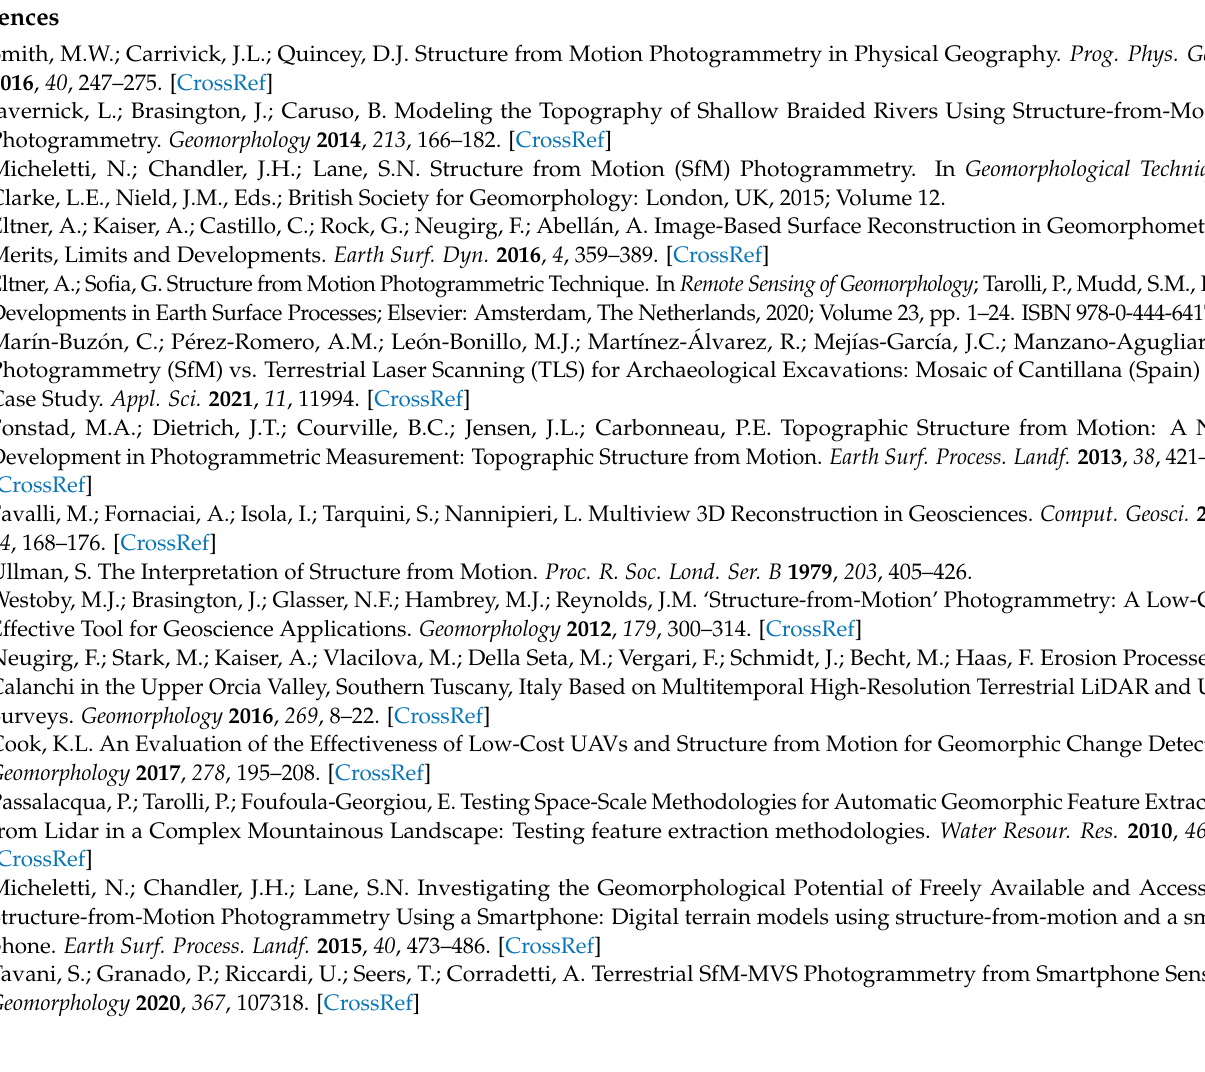
Figure A4. ( a ) 201718 Terr, ( b ) 201718 UAV, ( c ) 201819 Terr, ( d ) 201819 UAV, ( e ) 201719 Terr and ( f ) 201719 UAV. ( a – f ): Local level of detection for the multitemporal comparison of point clouds resulting from using terrestrial and aerial imagery in the 3D reconstruction. Gray colors in the point clouds reflect areas with no information point precision estimates available in any of the point clouds of the comparison pair. In the color scale the gray areas show that there are no values available, therefore they are indicating the range of the local levels of detection of the respective comparison pair.